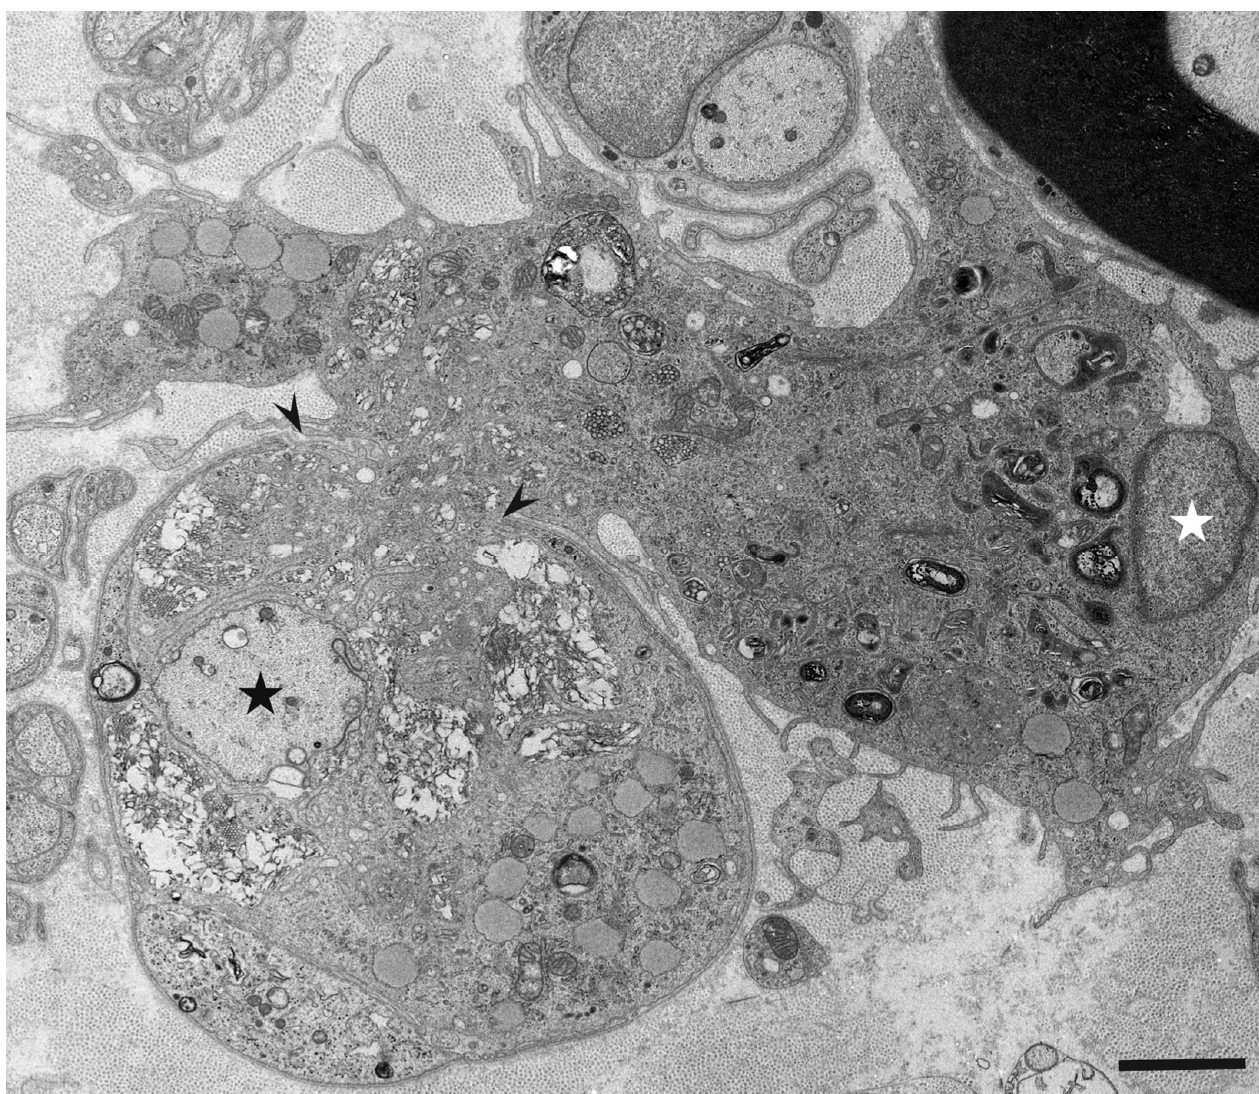
Figure 6. A macrophage escaping from the basement membrane tube surrounding the myelinated fiber. A cross section of a sural nerve biopsy specimen obtained from a patient with AIDP. The sites at which the basement membrane was disrupted are indicated by arrowheads. The nucleus of this macrophage is located outside of the basement membrane tube. Note that an axon located within the basement membrane tube is completely demyelinated. A demyelinated axon and a macrophage nucleus are indicated by a black asterisk and a white asterisk, respectively. Uranyl acetate and lead citrate staining. Scale bar = 2 m.